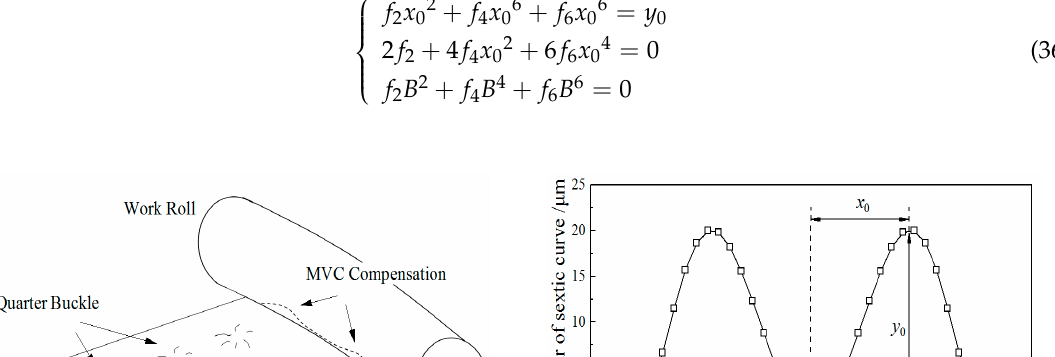
Table 3. Changes of the Δ ε 4 under different values of the quartic crown before and after the optimisation ( Δ T = 100 °C).